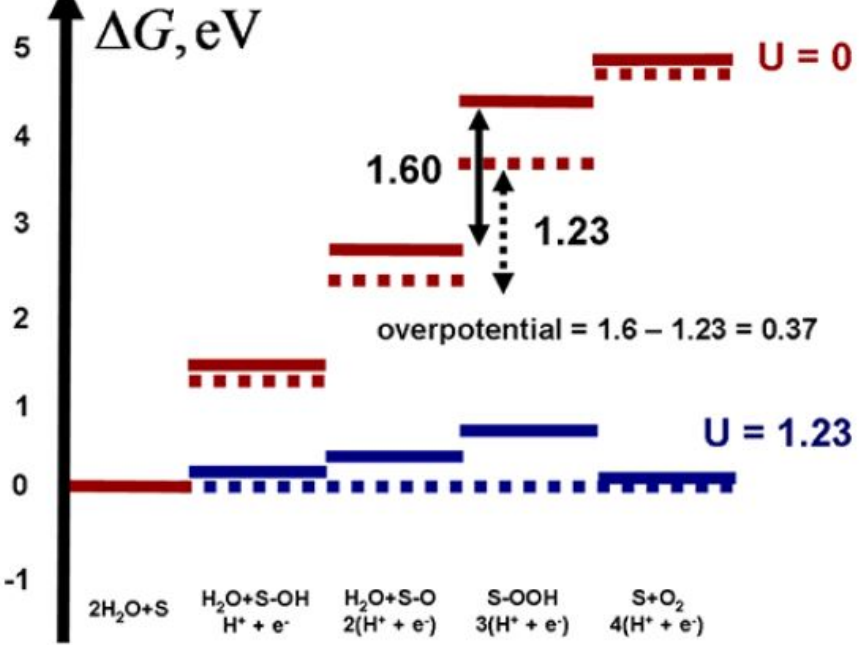
Figure 2. The free energy profile for the OER on TiO 2 . Reprinted with permission from ref. [58]. Copyright 2013 ACS.